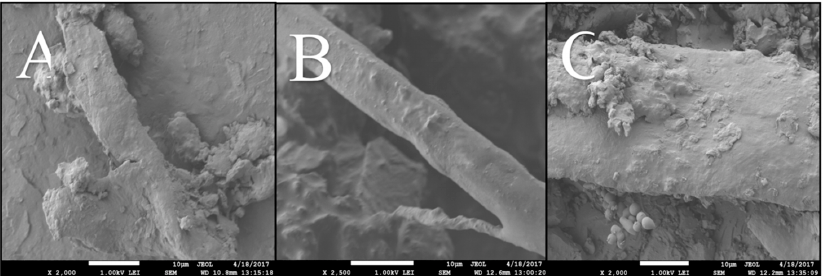
Figure 7. SEM images of ( A ) composite prepared with tung oil fatty acid resin, ( B ) composite prepared with tung oil methyl ester resin, and ( C ) composite prepared with a tung oil